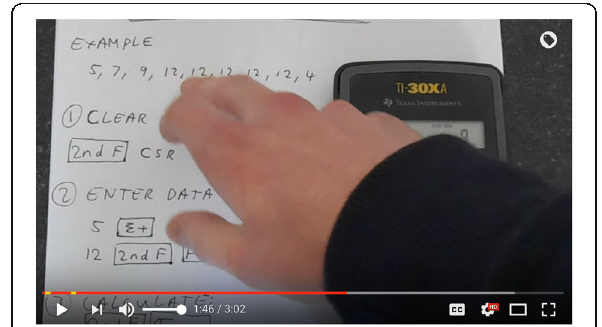
Fig. 4 Example of deictic gesture where speaker is pointing to data points with a